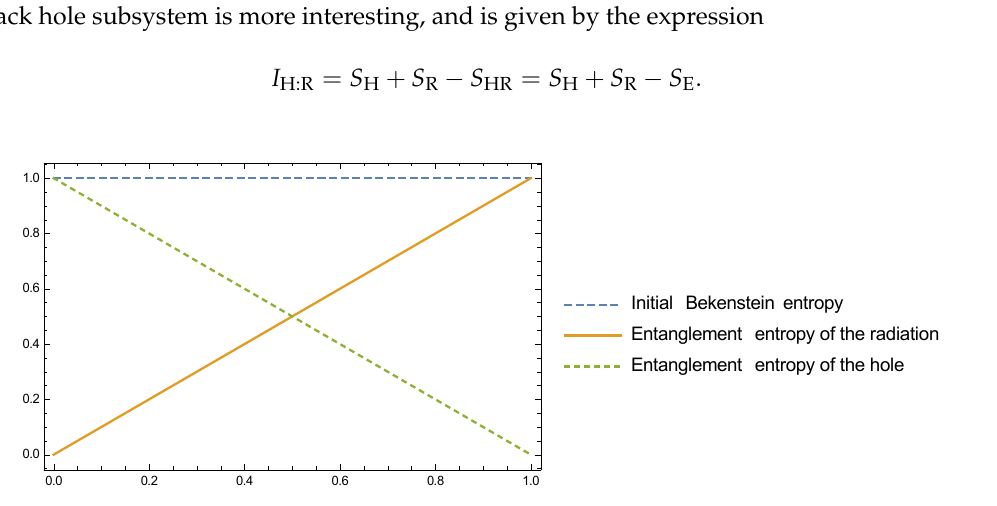
Figure 4. Tripartite quantum (von Neumann) entropy balance: Under the “average subsystem” assumption, now applied to a pure-state tripartite system consisting of (black hole) plus (Hawking radiation) plus (rest of universe), the quantum (von Neumann) analysis reproduces the Clausius (thermodynamic) analysis. As the black hole Bekenstein entropy decreases, the entanglement entropy of the radiation increases, to keep total entropy approximately constant, at least to within 1 nat. In the limit where the environment (rest of universe) becomes arbitrarily large, the correspondence is